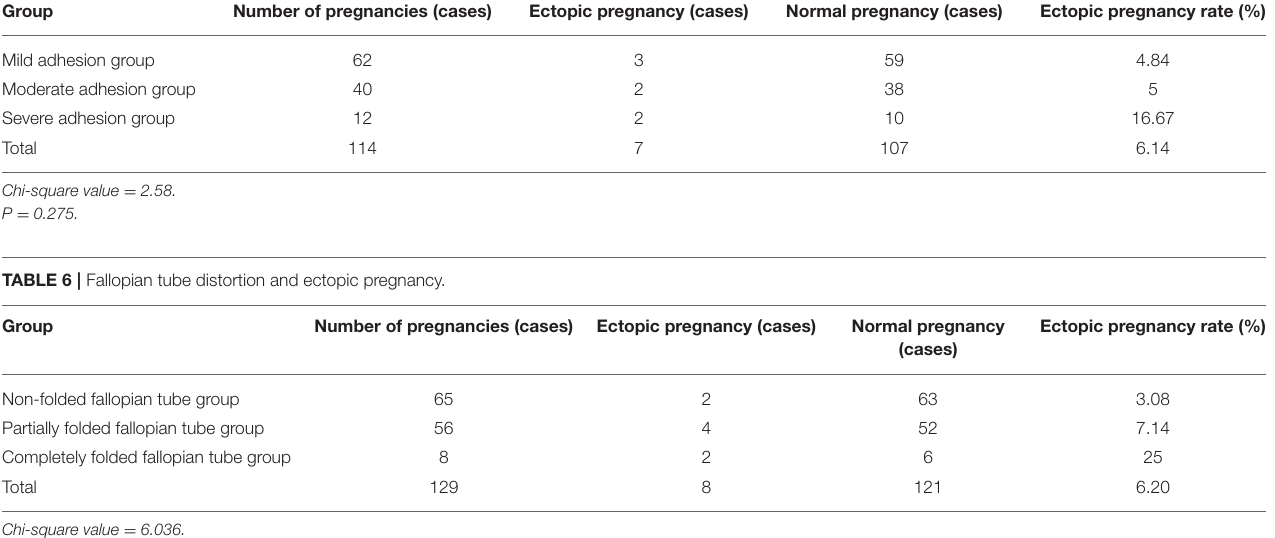
TABLE 5 | Pelvic adhesion and ectopic pregnancy. Group Number of pregnancies (cases) Ectopic pregnancy (cases) Normal pregnancy (cases)